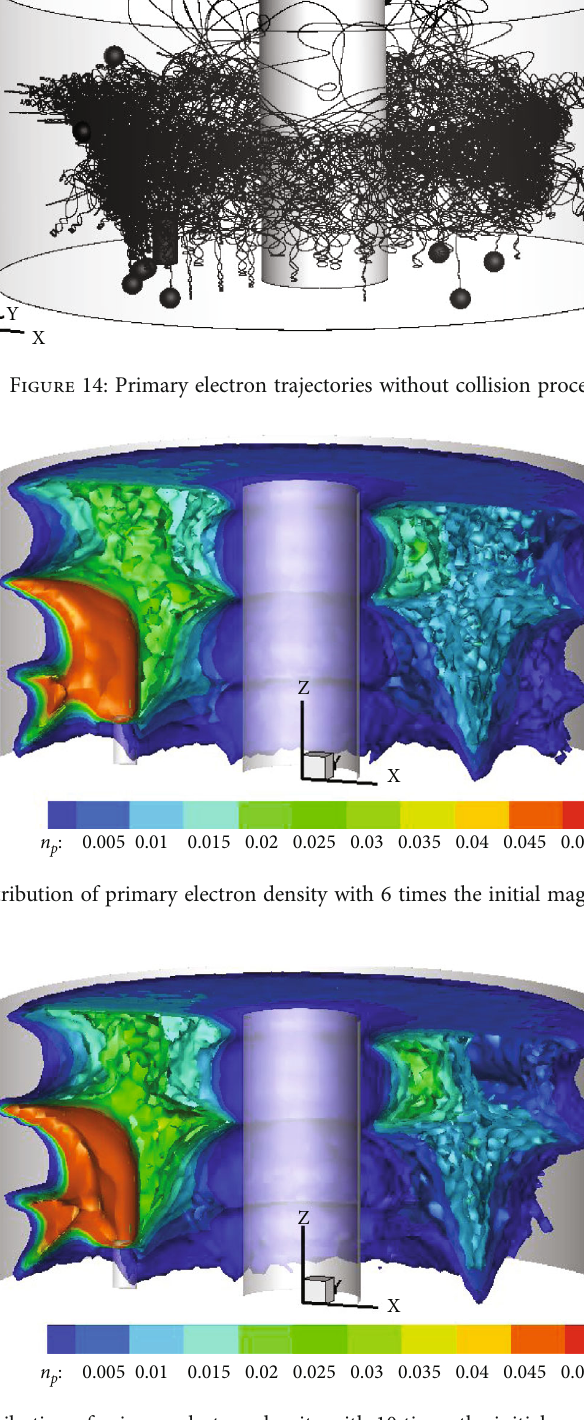
Figure 16: Distribution of primary electron density with 10 times the initial magnetic fi eld strength.